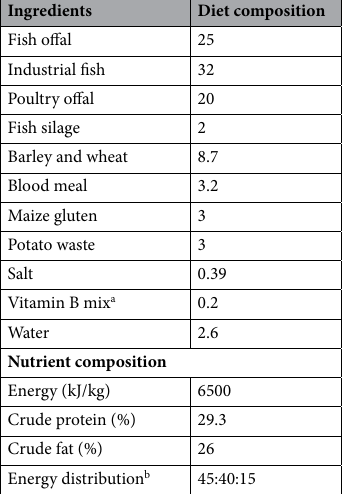
Table 4. Composition of basal diets (as fed, %). a Vitral B-mink super (Agro Korn A/S). B1, 3000 mg/kg;